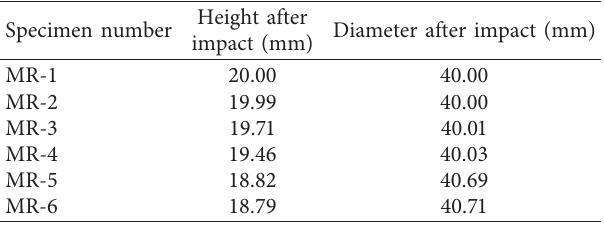
Figure 5: Stress-strain curves at different strain rates. Table 3: Specimen size parameters after